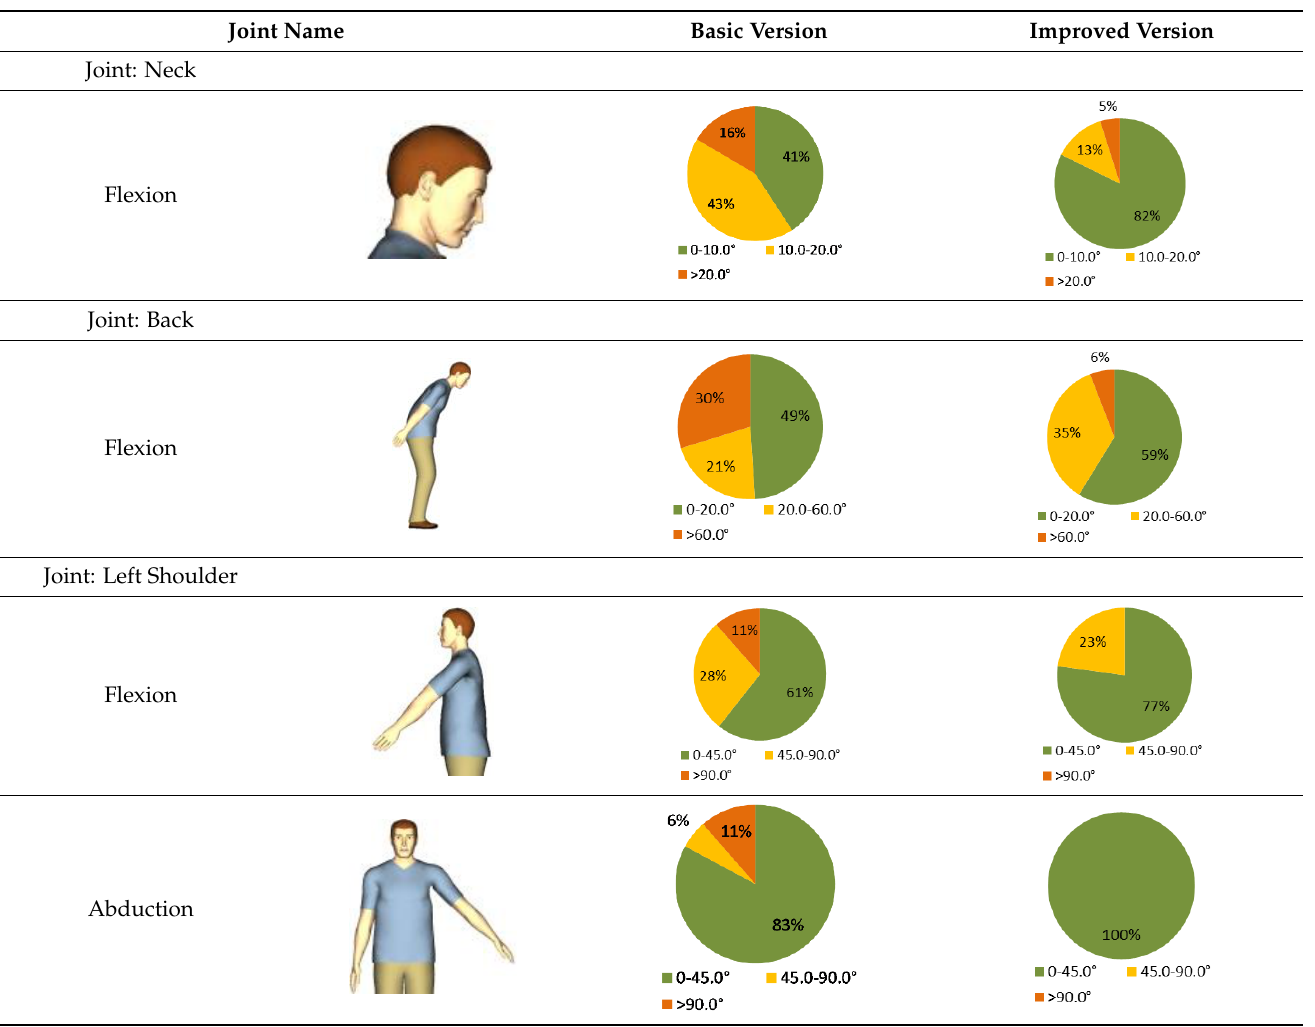
Table 3. Result of the analysis of the joints’ strain during the assembly process without (basic version) and with (improved version) smart tools implemented on the manual assembly workstation.